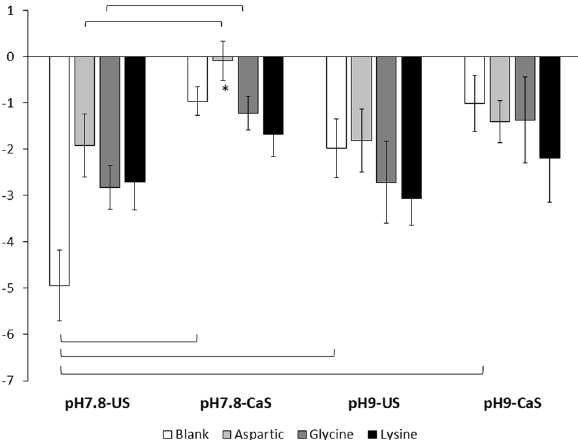
Figure 1. Zeta potential analysis of functionalized ns-nHA. Pre-conditioning of blank ns-nHA and addition of any of the amino acids studied notably increased the zeta potential (i.e. made it less negative). Of particular note is the near-neutral zeta potential of aspartic acid functionalized ns-nHA prepared under calcium-saturated and pH 7.8 conditions (indicated by * ). This balanced charge likely results from a more balanced binding of both carboxyl and amine groups to the ns-nHA surface (compared to the other amino acids). Data reported as average ± one standard deviation (n = 5). ns-nHA unsaturated with calcium is given as US, while that pre- saturated with calcium is given as CaS. Horizontal bars indicate statistically detectable difference (p <